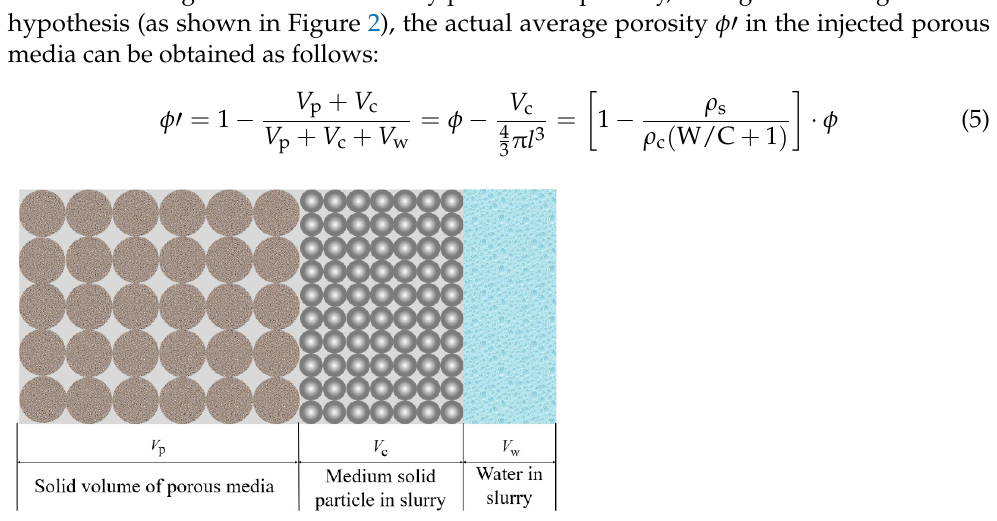
Figure 2. Volume distribution of each component in the grouting